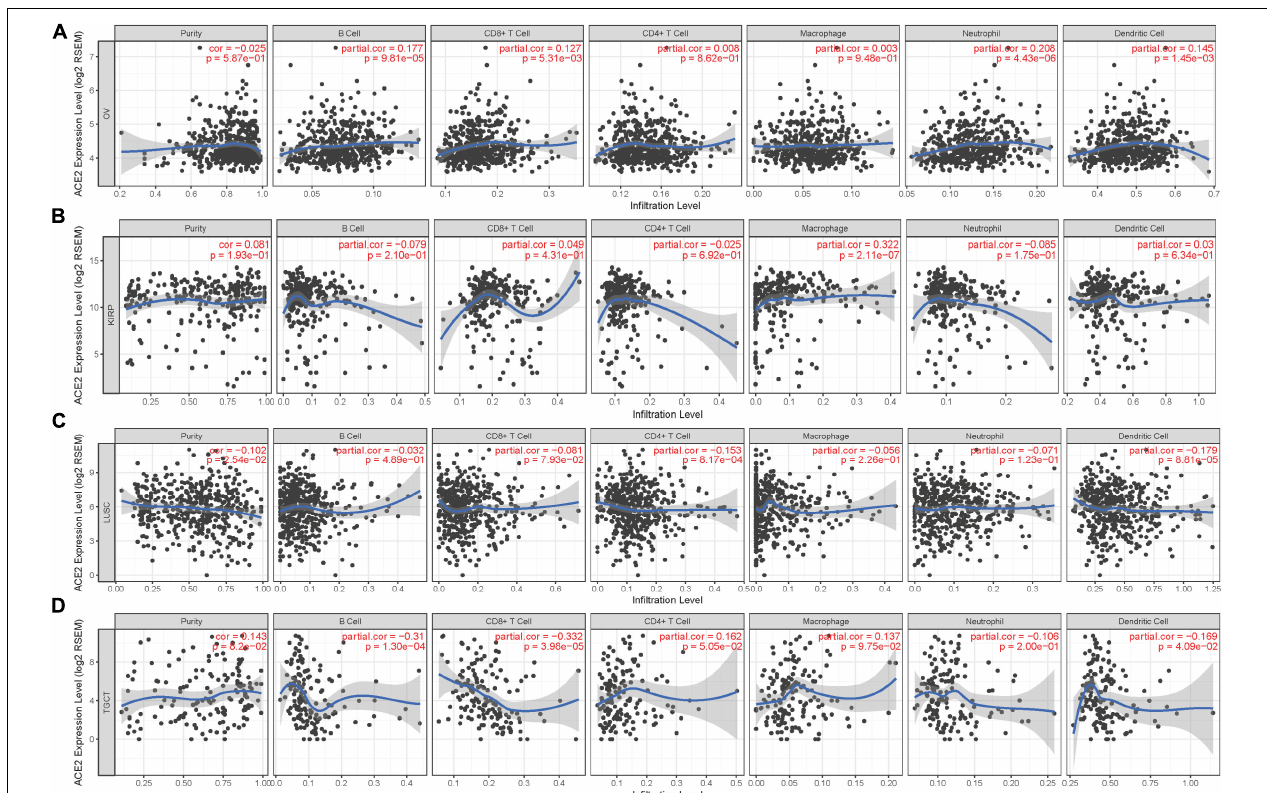
FIGURE 4 | Correlation of ACE2 expression with immune infiltration level. (A) ACE2 expression has no relation with tumor purity and significant positive correlation with infiltrating levels of B cell, CD8 + T cell, neutrophil, and dendritic cell in OV. (B) ACE2 expression has no relation with tumor purity and significant positive correlation with infiltrating levels of macrophage in KIRP. (C) ACE2 expression has significant positive correlation with tumor purity, significant negative correlation with infiltrating levels of CD4 + T cell and dendritic cell in LUSC. (D) ACE2 expression has no relation with tumor purity and significant negative correlation